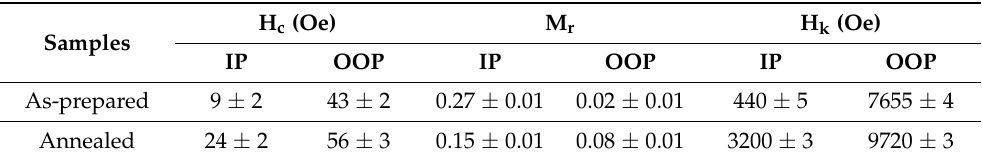
Table 2. The magnetic parameters of Co 2 MnSi glass-coated microwires of as-prepared and annealed samples in IP and OOP